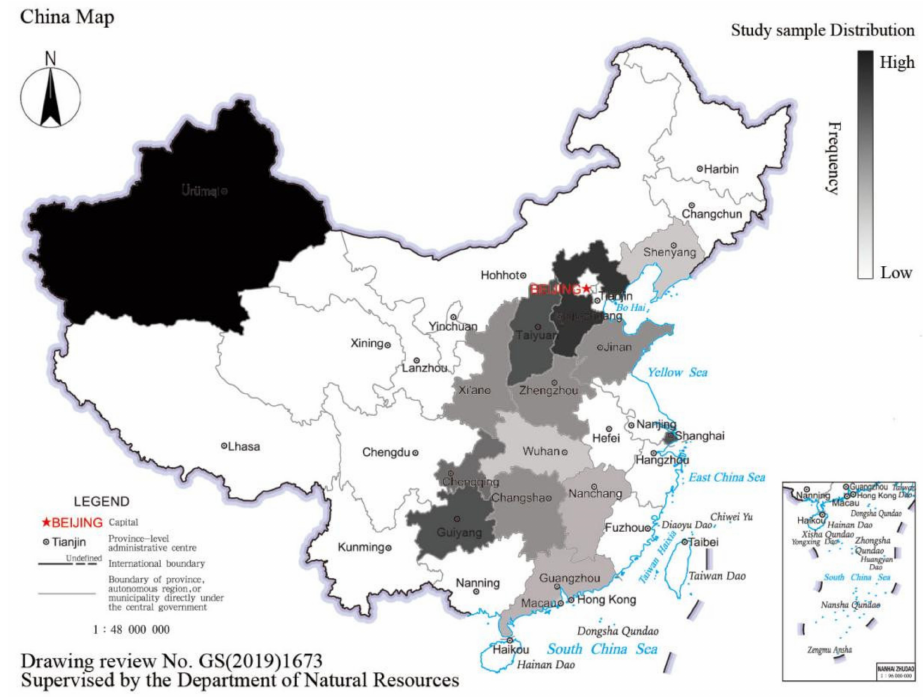
Figure 2. Geographical location distribution of study